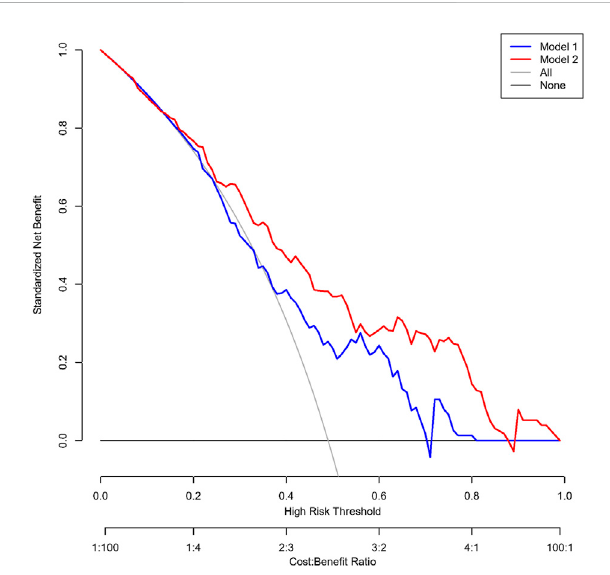
FIGURE 2 Calibration curve for the novel prediction model in propensity- score-matched population. Caption: BS, bootstrapping. The red line is the ideal reference calibration line, and the black curve is the actual observed calibration curve. The x-axis indicates the predicted risk of TBAD formation, and the y-axis indicates the observed risk of TBAD formation. The yellow area indicates the 95% con fi dence interval of the observed risk generated from 1,000 time bootstrapping.